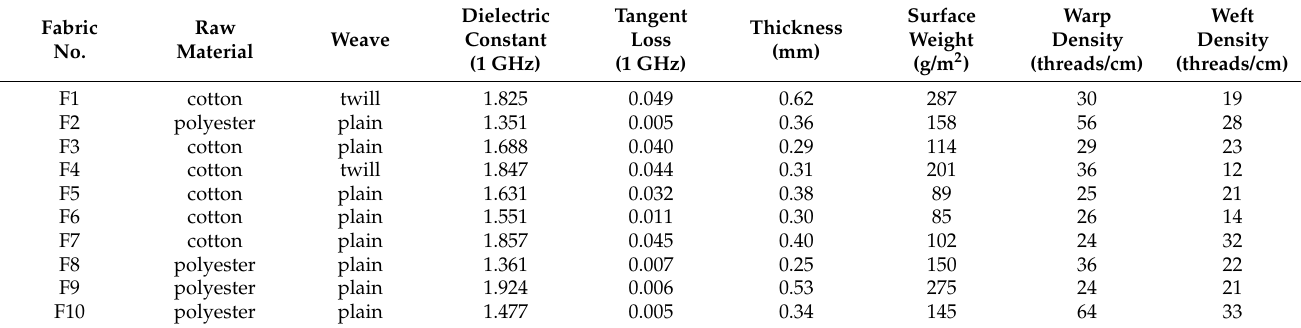
Table 2. Basic parameters of the fabrics used as a textile substrate of the tested lines.